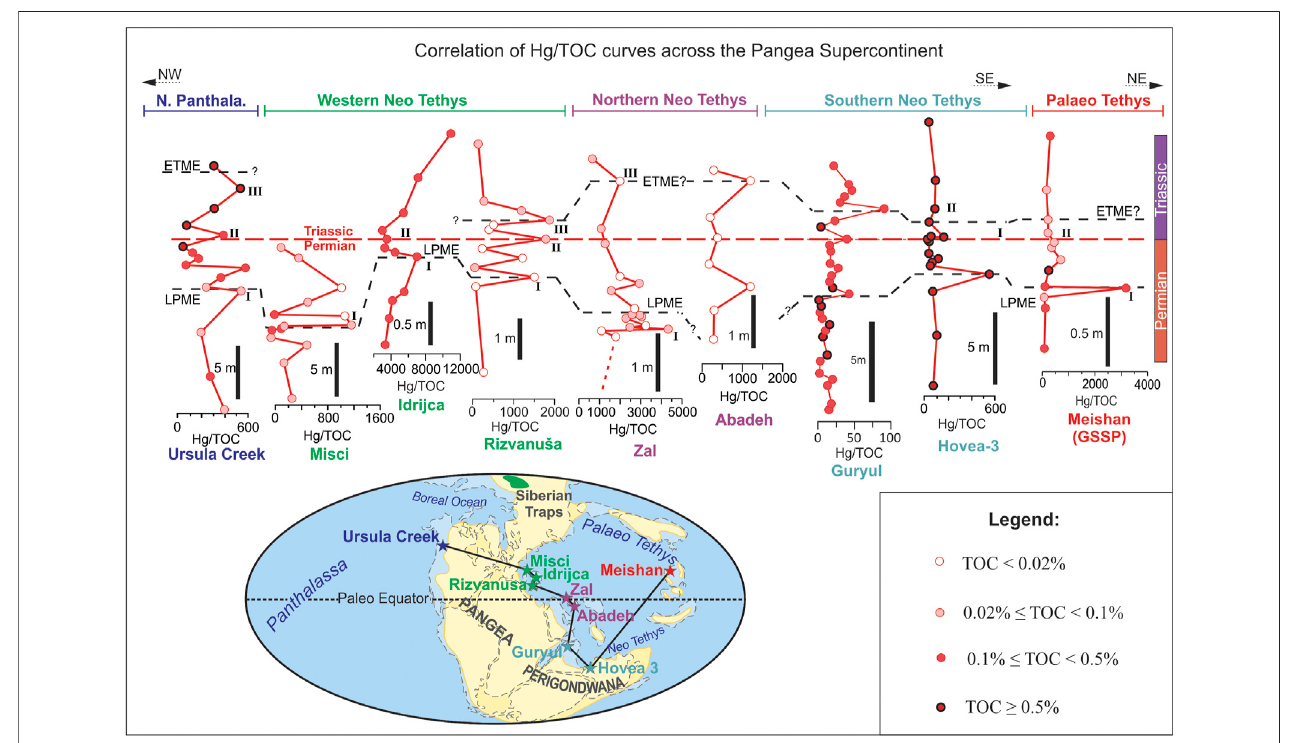
FIGURE 6 | A NW – SE Hg/TOC transect across the Pangea supercontinent (252 Ma ago) encompassing nine PTB sections, from Ursula Creek (Canada) through Hovea-3 (Australia), including Meishan D and Guryul sections based on Sial et al. (2020a). In building this transect, the position of the LPME and ETME horizons have been kept as shown in their original Figures and the PTB datum was used for